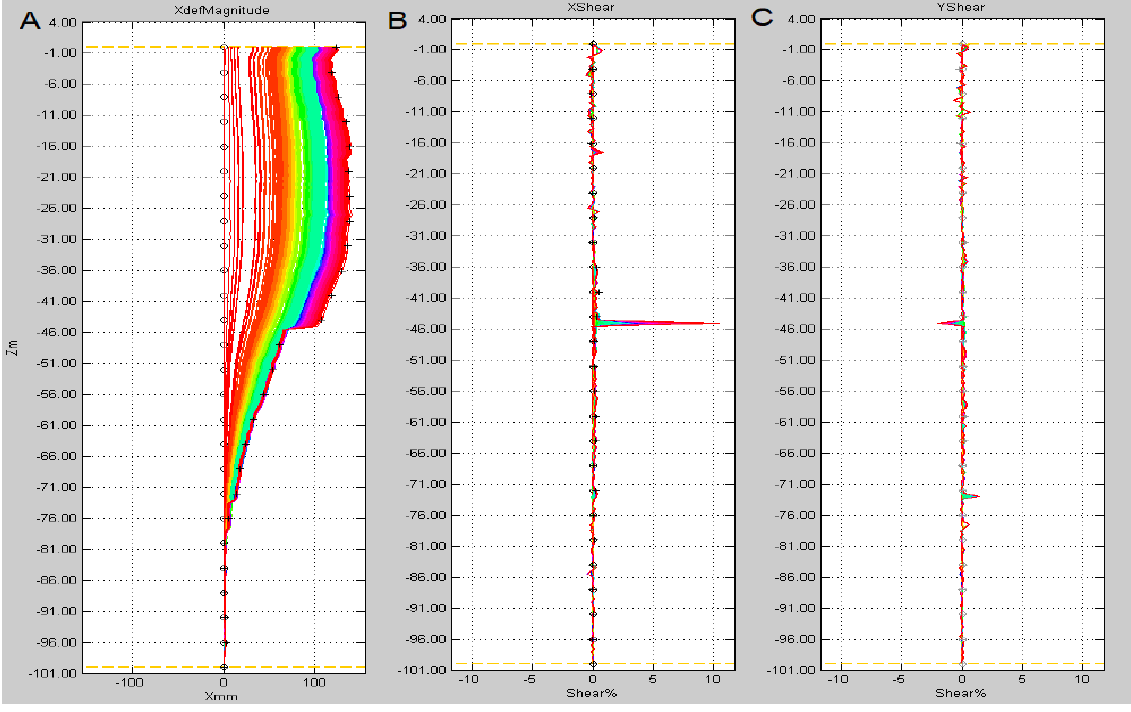
Figure 10. Magnitude of displac. (A), X shear stress (B), Y shear stress (C), Belchatow